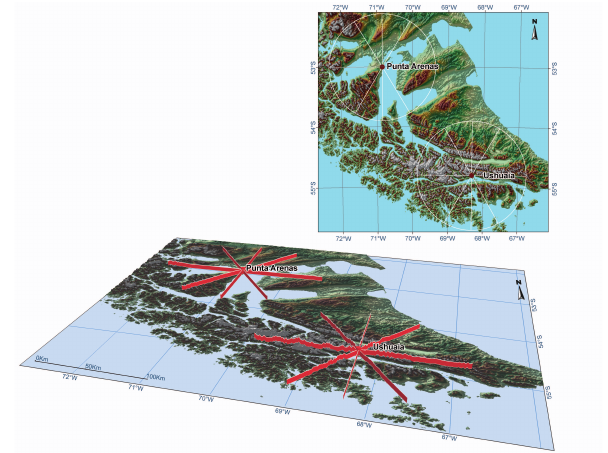
Fig. 1. Topographic map of the study region derived from NASA STRM 90m Digital Elevation Data (available at: http://srtm.csi. cgiar.org/). Punta Arenas, Chile, and Ushuaia, Argentina, are la- belled. Extending from each city are 100km-long radial “ribbons” that highlight vertical topography in directions of N, NE, E, SE, S, SW, W and NW. Data are projected using Lambert conformal conic projection with a central meridian of 70degrees west and standard parallels at 5 and 42degrees south. This projection has correctly de- scribed the form of the study region at the expense of introducing distortion in the representation of bearings from the two sampling points illustrated. The open seawater within the 100km radius of Punta Arenas is visibly